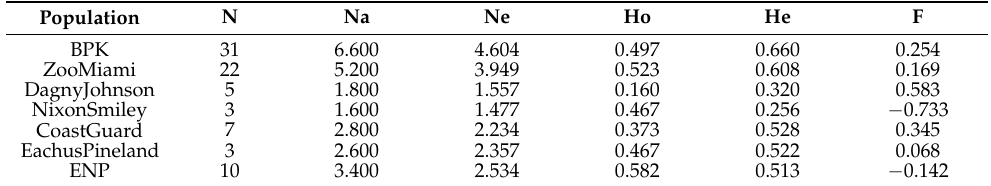
Table 1. Population-level statistics for E. b. floridensis from 7 population locations (conservation properties) in South Florida. N, sample size; Na, number of different alleles; Ne, number of effective alleles; Ho, observed heterozygosity; He, expected heterozygosity; F, Fixation Index = (He − Ho)/He = 1 − (Ho/He); BPK, Big Pine Key (within National Key Deer Refuge); ENP, Everglades National Park. Big Pine Key and Dagny Johnson are island populations; all other populations exist on the Florida